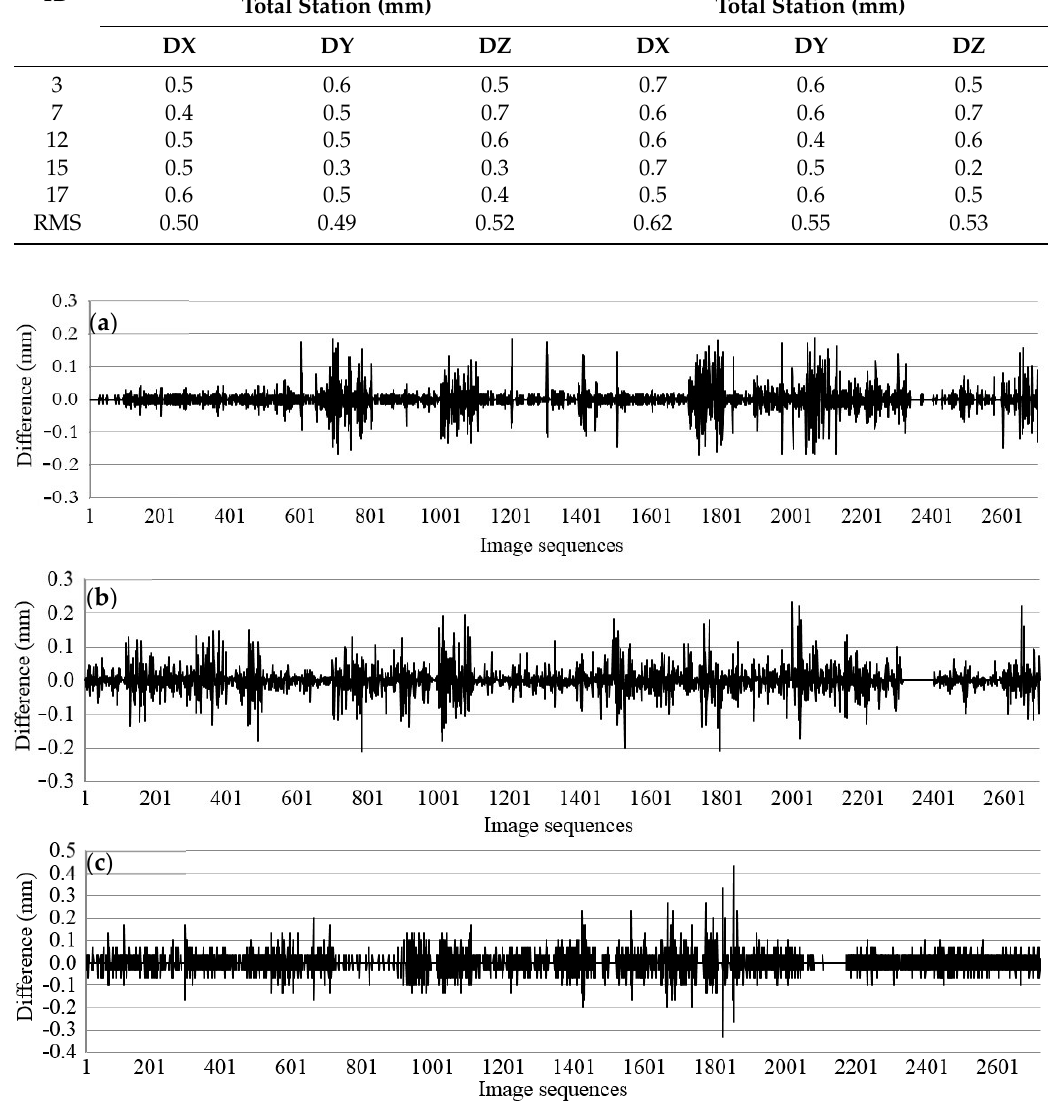
Figure 8. The curves of the coordinate difference between the tri-camera videogrammetry and two-camera videogrammetry in the three directions. ( a ) Coordinate difference between the tri-camera videogrammetry and the two-camera videogrammetry in the X direction, ( b ) coordinate difference between the tri-camera videogrammetry and the two-camera videogrammetry in the Y direction, and ( c ) coordinate difference between the tri-camera videogrammetry and the two-camera videogrammetry in the Z direction.